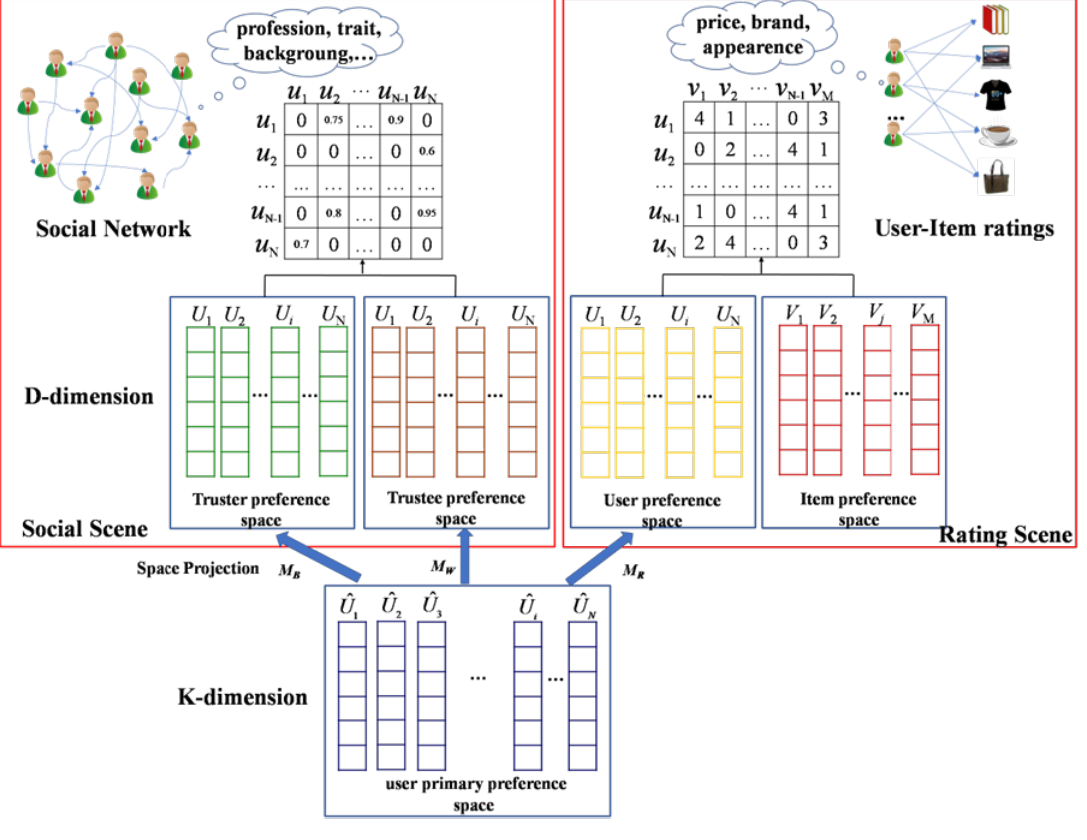
Figure 6. The overview of the UPPS model.